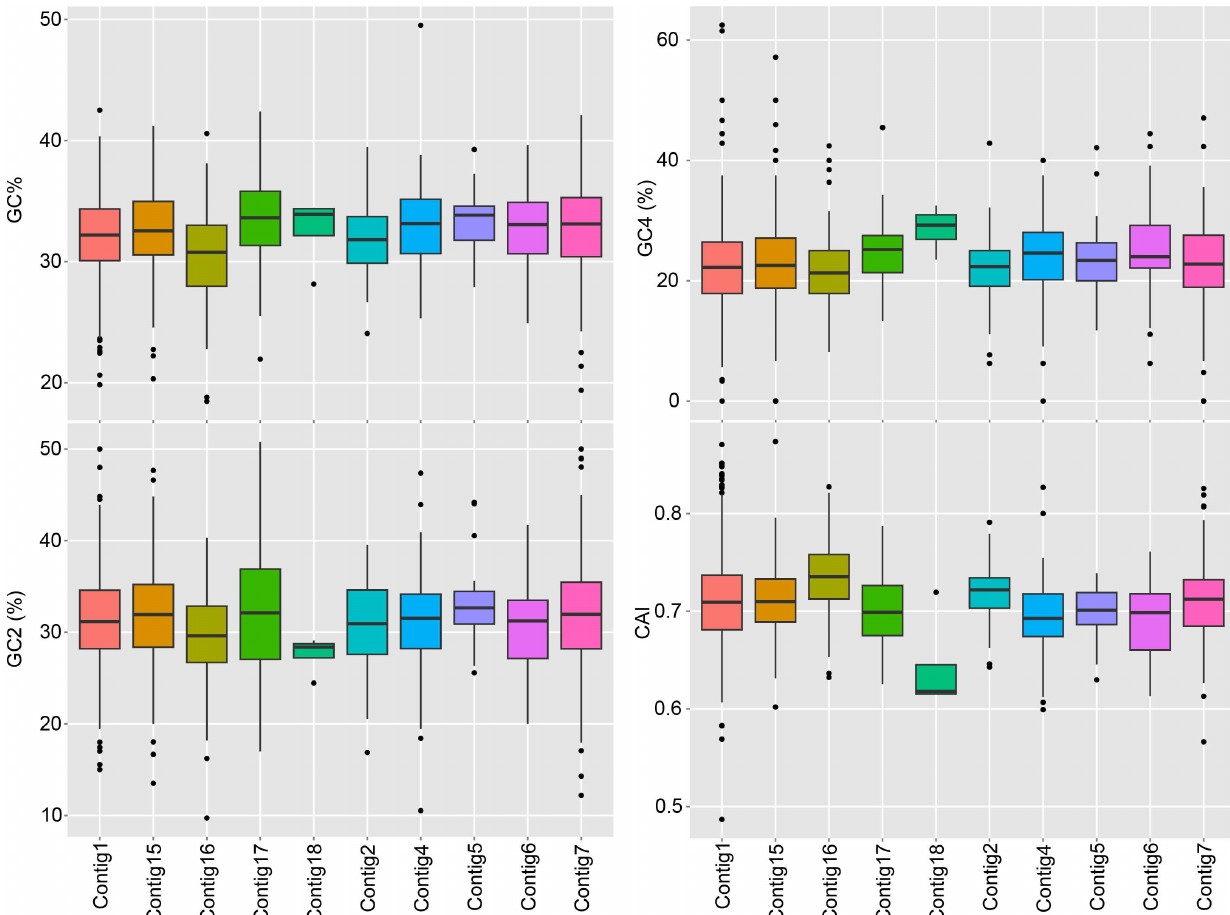
Figure 12. The ten contigs assigned to the Ca. X. pacificiensis genome from the metagenomic assembly have similar nucleotide composition. Boxplots are shown comparing GC% (top left), GC2 (bottom left), GC4 (top right) and CAI (codon adaptation index [49], bottom right) in contigs assembled from metagenomic sequence obtained from L. patella animal L6 and assigned to Ca. X. pacificiensis. The sizes of the contigs are shown in Table 6. Only Contig16 was found to have a statistically significant difference in nucleotide composition to any other contig (see Main Text, Table S2). doi:10.1371/journal.pone.0080822.g012 PLOS ONE |